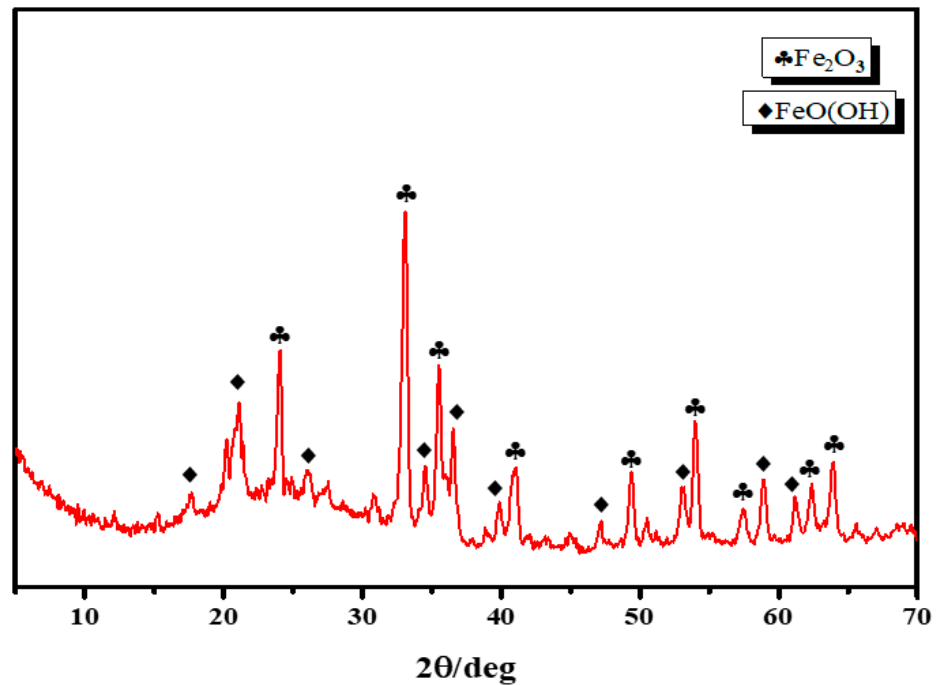
Figure 8. XRD patterns of Fe 2 O 3 calcined precipitate.